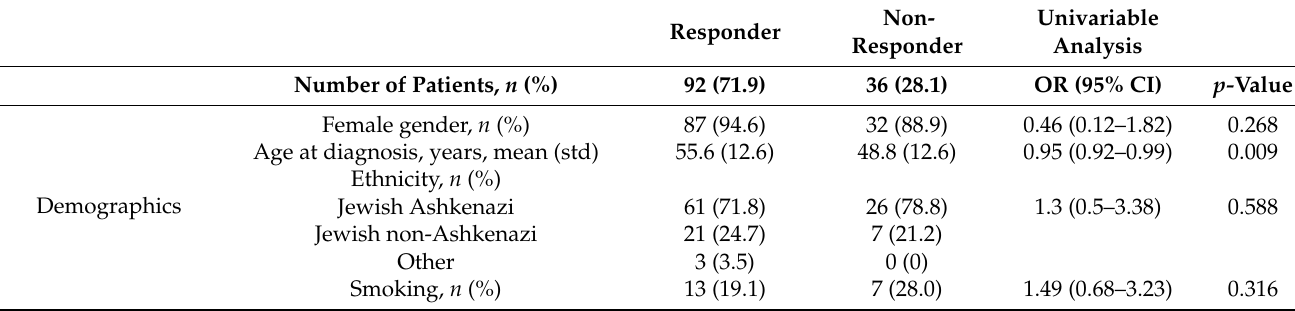
Table 3. Univariable analysis for parameters associated with UDCA non-response using Toronto